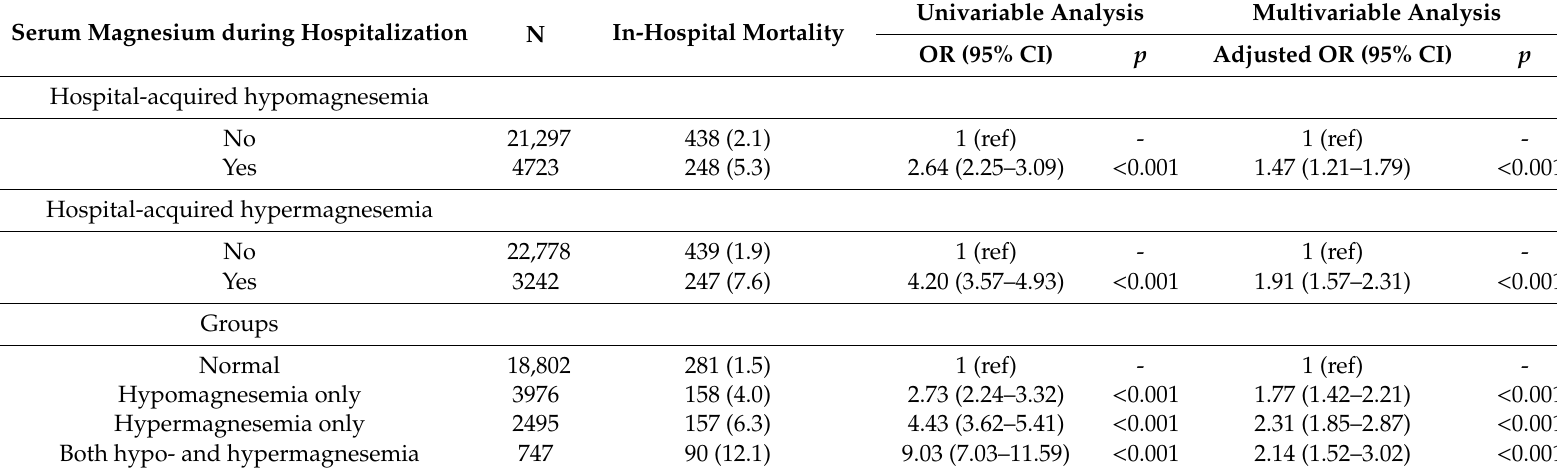
Table 2. Association between hospital-acquired serum magnesium derangements and in-hospital